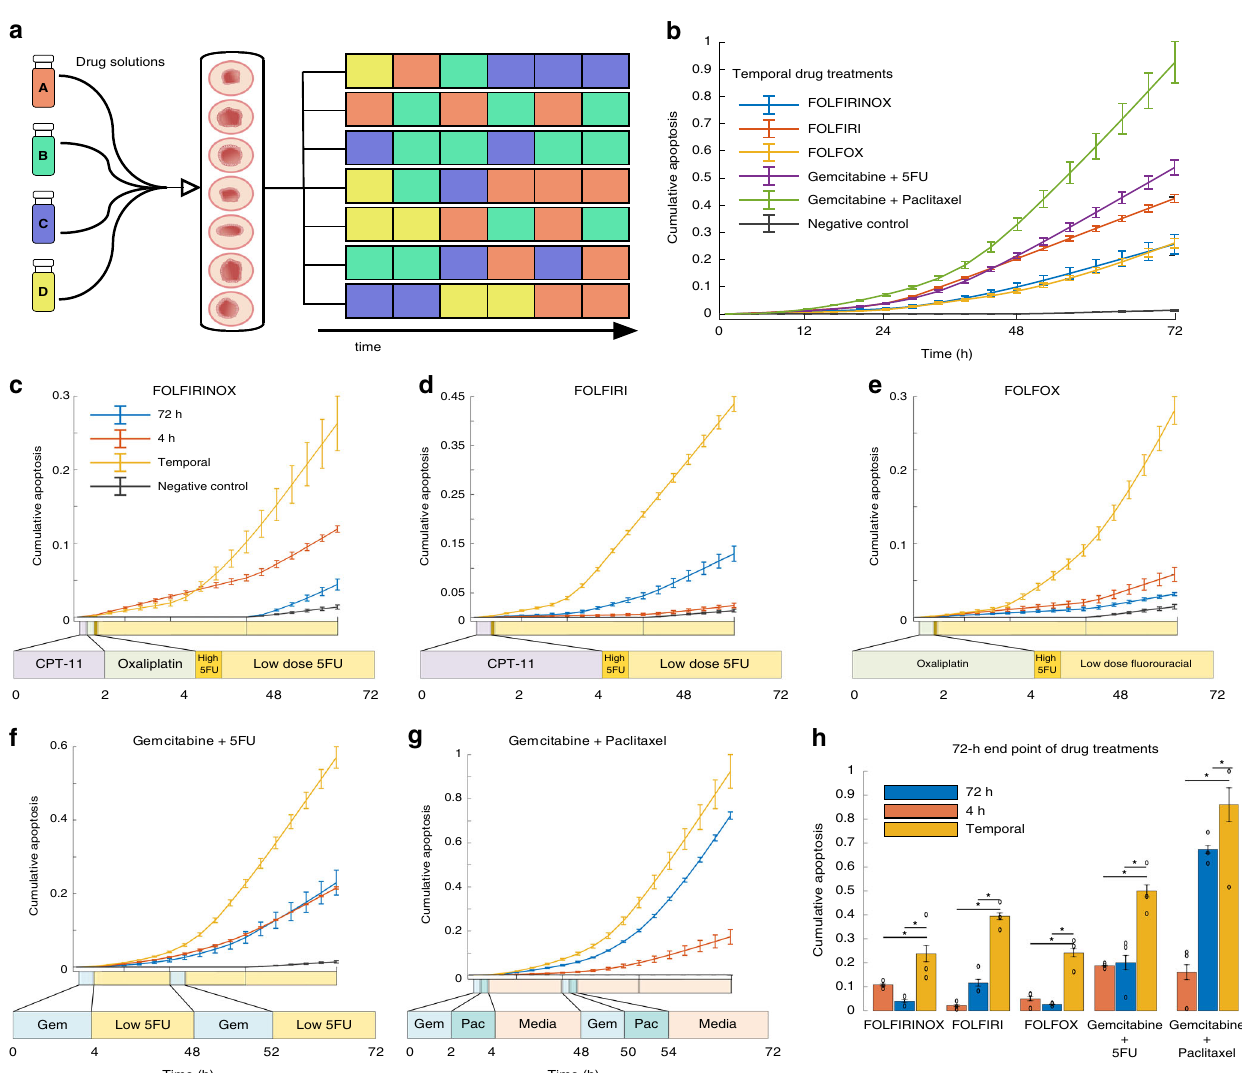
Fig. 4 Sequential and temporal drug treatment on the micro fl uidic platform reveals the ef fi cacy of dynamic temporal drug treatment for personalized therapy. a Schematic of sequential drug delivery schedules of single drugs delivered temporally in pulses to recapitulate dynamic combination chemotherapy with the platform. Colors in each row represent a different drug formulation, which can be changed on-demand. b – h Comparison of the temporal delivery for fi ve combination chemotherapies using average caspase 3/7 signal to detect apoptosis for patient 1. All data presented as mean values ± SEM, n = 3, and normalized to positive control. c – g Comparison of temporal delivery for each of the fi ve combination chemotherapies to their 72-h and 4-h constant delivery counterparts (i.e., all drugs in the sequence at once). Details of the drugs used in each therapy regimen are shown below the graph and described in more detail in Table 1. Time course of each drug on the x -axis is to scale. h Comparison of all investigated therapies at the end of the 72-h drug treatment period (asterisk denotes signi fi cant differences from temporal treatment, two-way ANOVA, p values from left to right; FOLFIRINOX: 8.3E-07, 7E-07; FOLFIRI: 1.7E-06, 7E-07; FOLFOX: 0.03, 0.01; Gem + 5-FU: 3.9E-05, 8.3E-05; Gem + Pac: 9.6E-10, 6.16E-06). Sequentially-administered combination therapy is more ef fi cient in inducing tumor cell death. Source data for panels c – g are